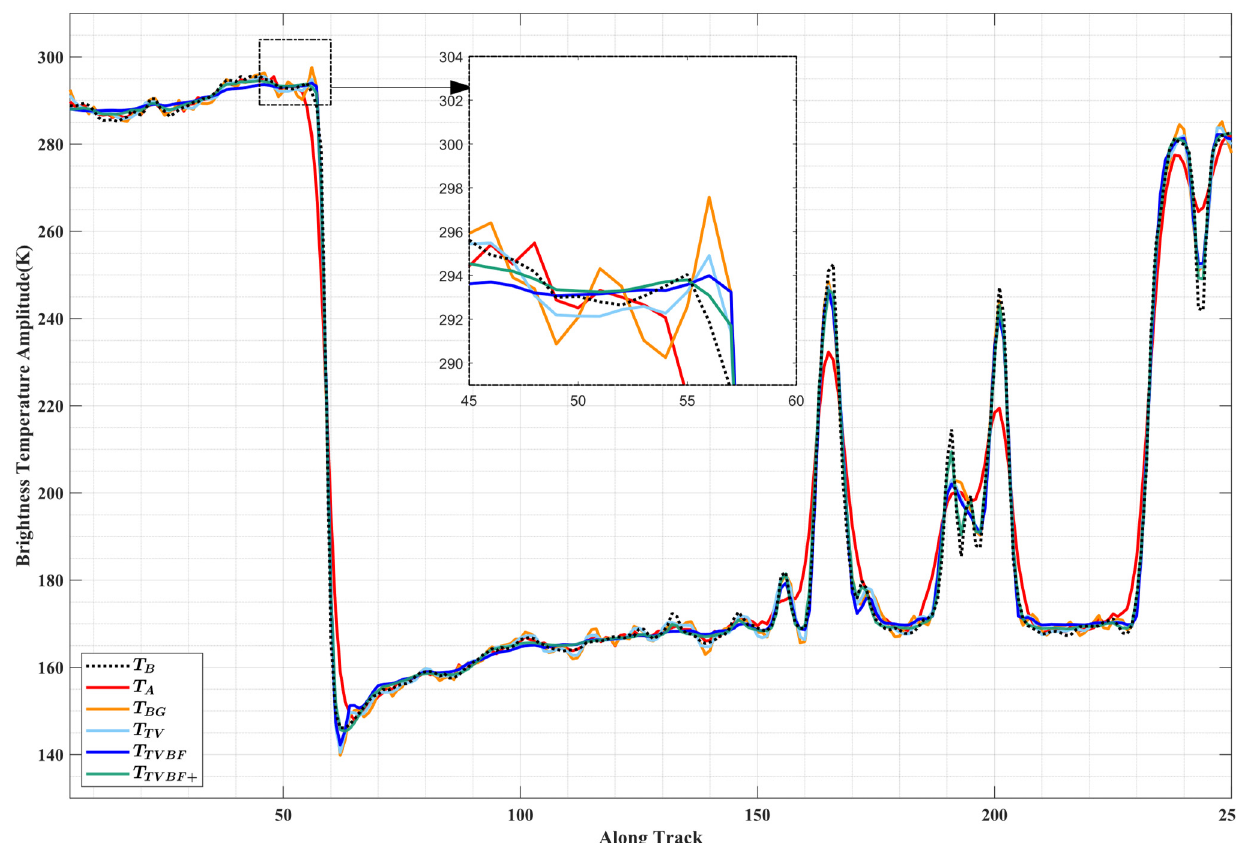
Figure 12. The along-track transects of the synthetic MWRI scenario (labeled with the dash-dotted line in Figure 11a). Table 3. The averaged evaluation indices of the 200 synthetic MWRI